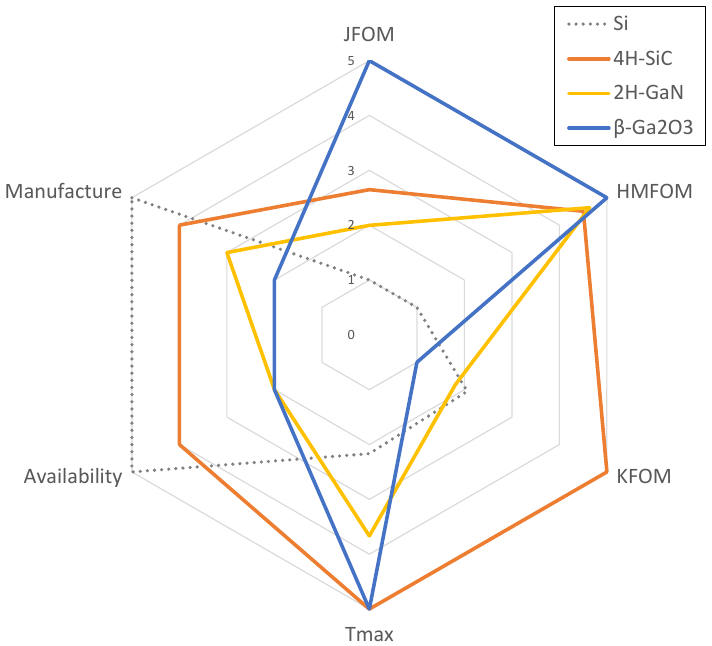
Figure 3. Comparison of the most important properties of semiconductors for smart grid